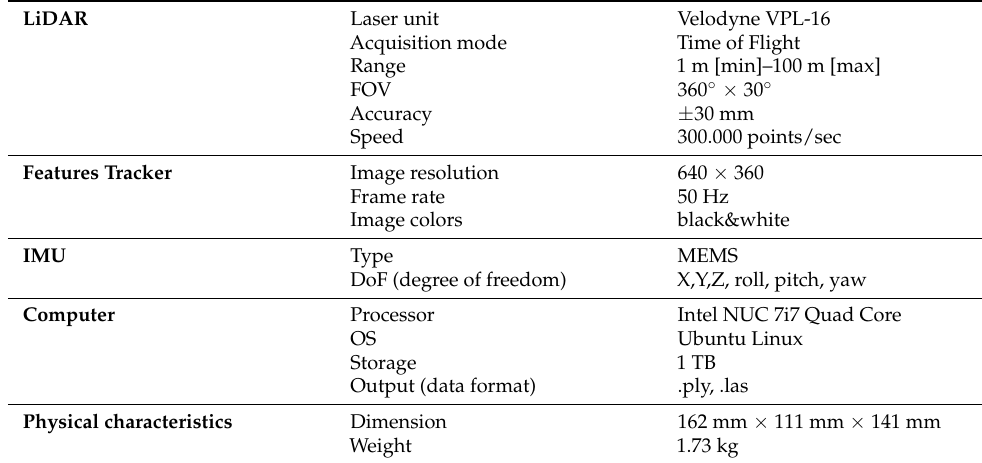
Table 1. Technical specifications of the MMS Kaarta Stencil 2–16.